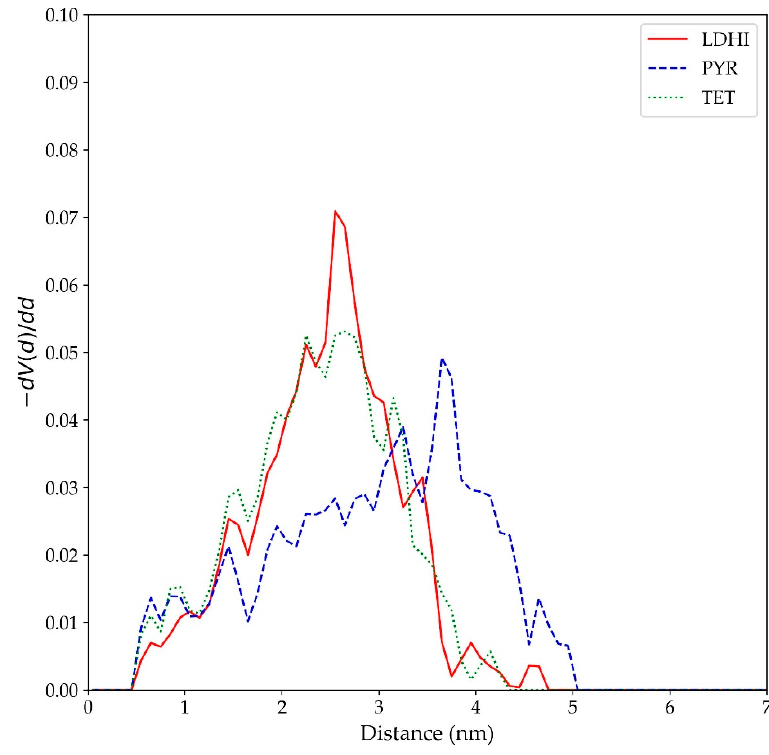
Figure 11. Pore size distributions for the large nanosphere models (lDHI: red; PYR: blue; TET: green) in implicit solvent. V(d) refers to the accessible volume of a cavity (“pore”) of a diameter d .